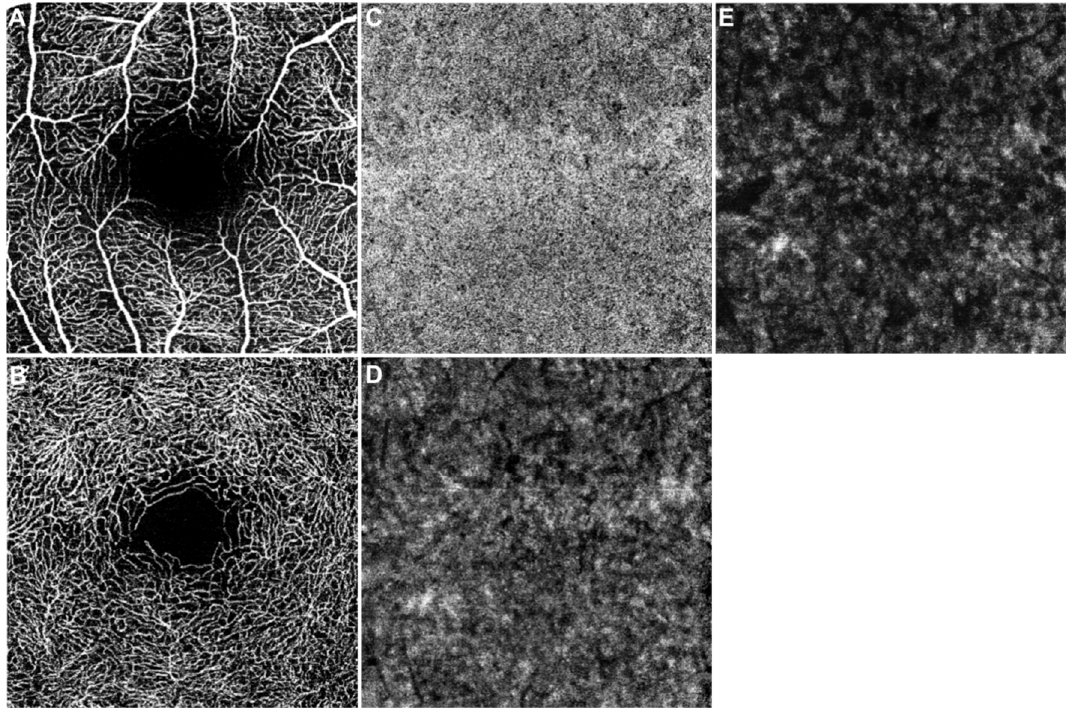
Figure 1. OCTA-imaging of the posterior pole in a healthy participant (15° × 15°). En face angiogram (raw data) of the superficial capillary plexus ( A ), deep capillary plexus ( B ), choriocapillaris ( C ), Sattler’s layer ( D ), and Haller’s layer ( E ).